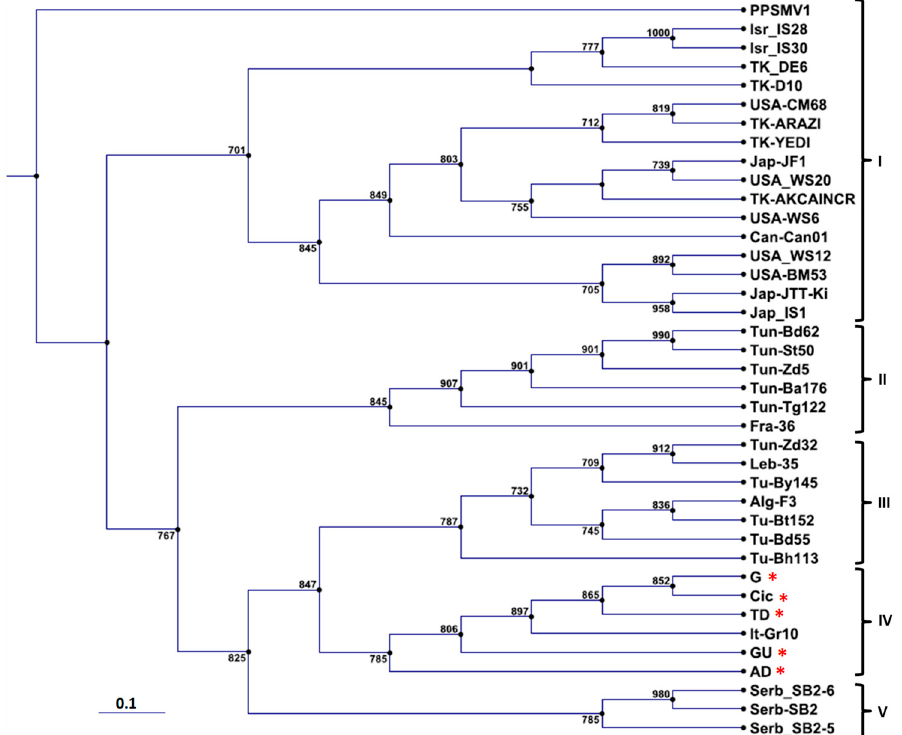
Figure 2. Phylogenetic tree constructed with the partial nucleotide sequences of RNA-3 (304 nt) of FMV isolates obtained in this study (labeled with an asterisk) and those retrieved from Genbank (32 isolates). Accession numbers of sequences used: AD (LS997754), G (LS997755), GU (LS997756), TD